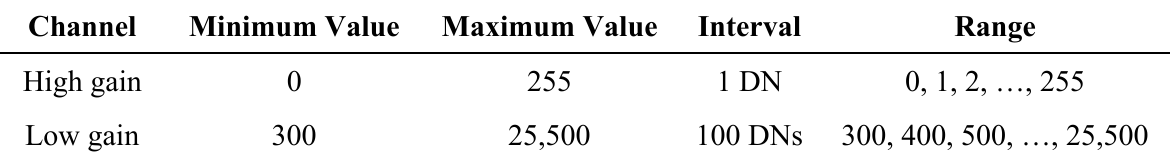
HD-ER raw data 6